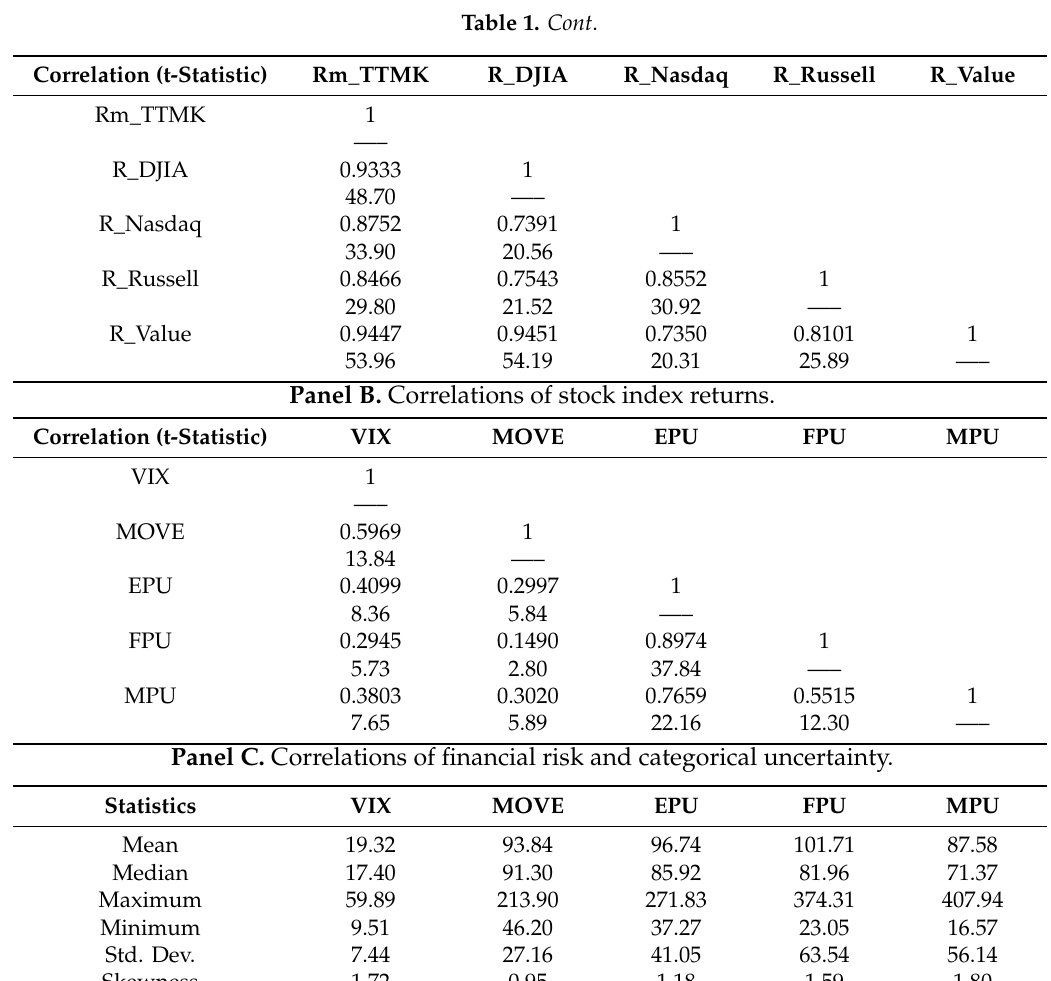
Panel C. Correlations of financial risk and categorical uncertainty.